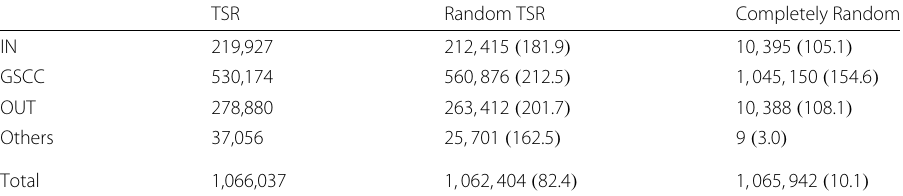
the IN and OUT components are not as separated as the two wings of a bow-tie, they are more similar to two halves of a walnut shell, surrounding the central GSCC